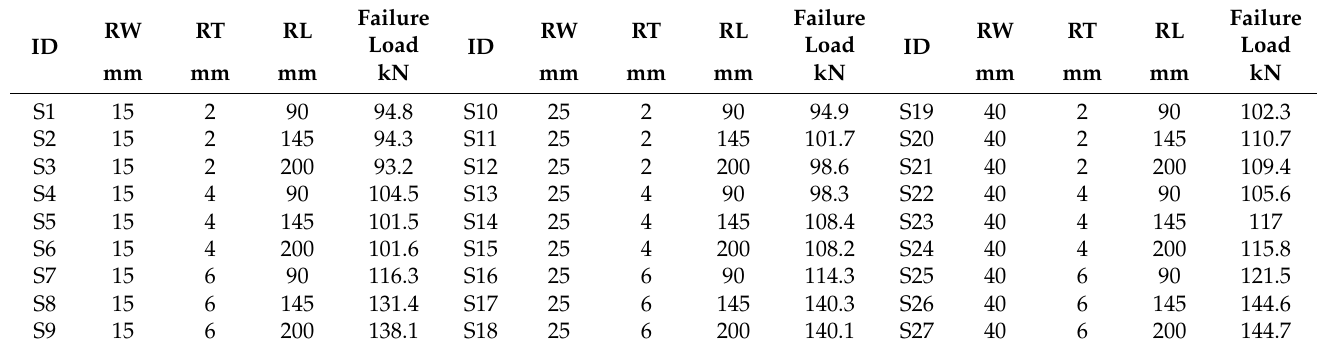
Table 4. Repair parameter design and failure load of ORLs of structural repair model.